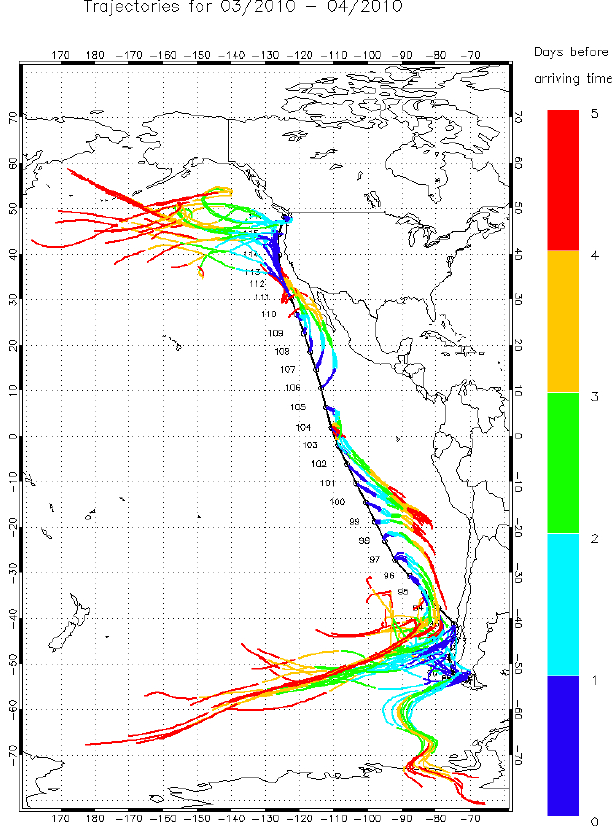
Fig. 1. The cruise track along with the 5-day back trajectories, cal- culated using HYbrid Single-Particle Lagrangian Integrated Trajec- tory (HYSPLIT), arriving during noon on every day of the cruise (Draxler and Rolph,